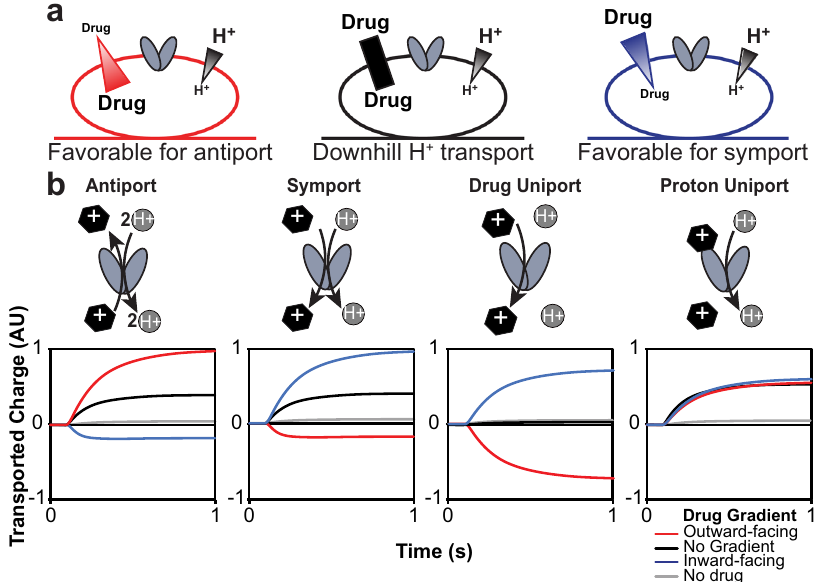
Fig. 4 | Determination of transport mode in vitro using solid-supported membrane electrophysiology (SSME). Expected resultsinthe SSME assay for the different transport modes of EmrE as predicted by the Free Exchange Model. a Threeconditionsare used to determine the transportmodeofEmrEusing SSME. Inallcases,thereisatwofoldinward-drivenprotongradient(pH7.0outsideandpH 7.3 inside). To test for antiport (red), a 16-fold substrate gradient was pointed against the proton gradient. For symport (blue), the 16-fold drug gradient is orientedwith the proton gradient. Athirdconditiontesting the presenceof a drug